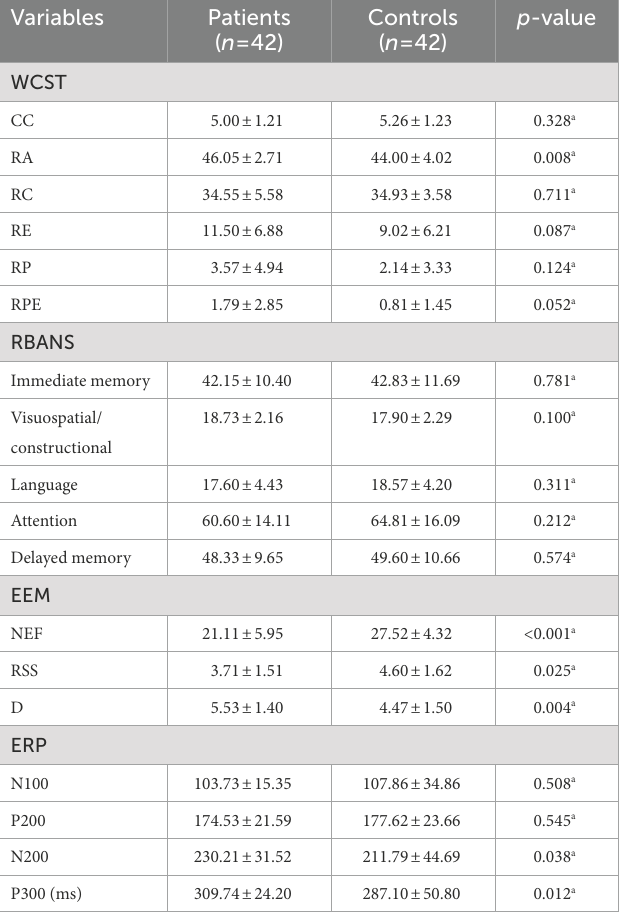
TABLE 3 Comparison of patients and healthy controls in cognitive status. Variables